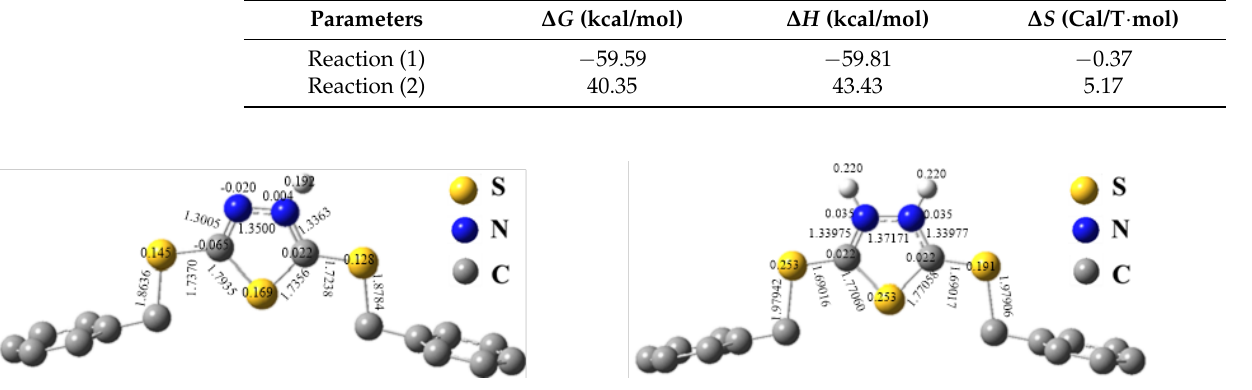
Figure 9. The optimized structure and Mulliken atomic charge of the protonated model molecule of PS-DMTD (at B3LYP/6-31G**/SDD level). PS-DMTD (at B3LYP/6-31G**/SDD